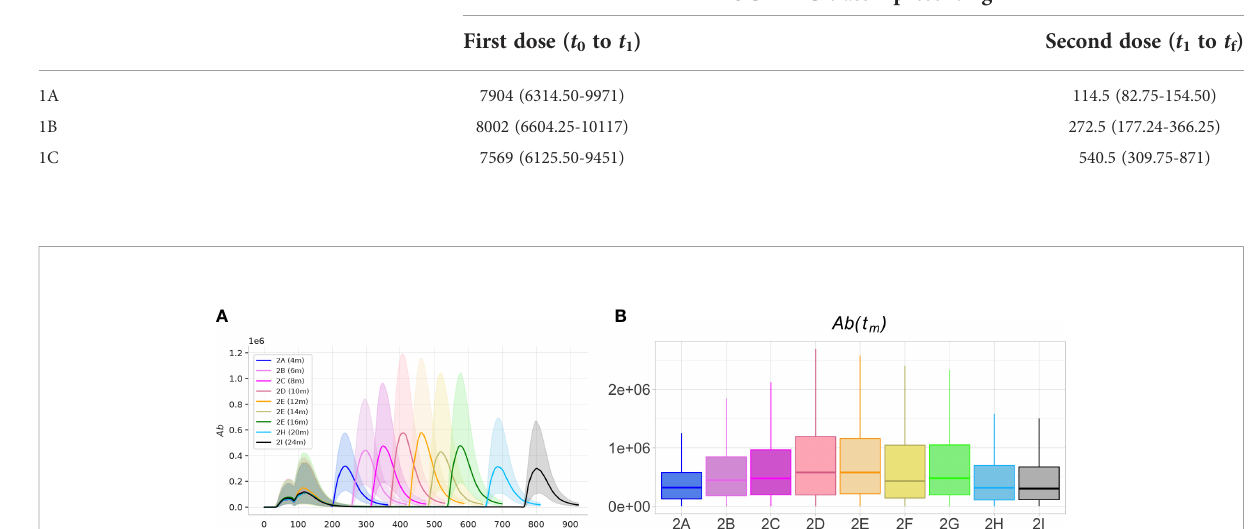
TABLE 2 Antigen presentation on MHC class I in muscle cells.